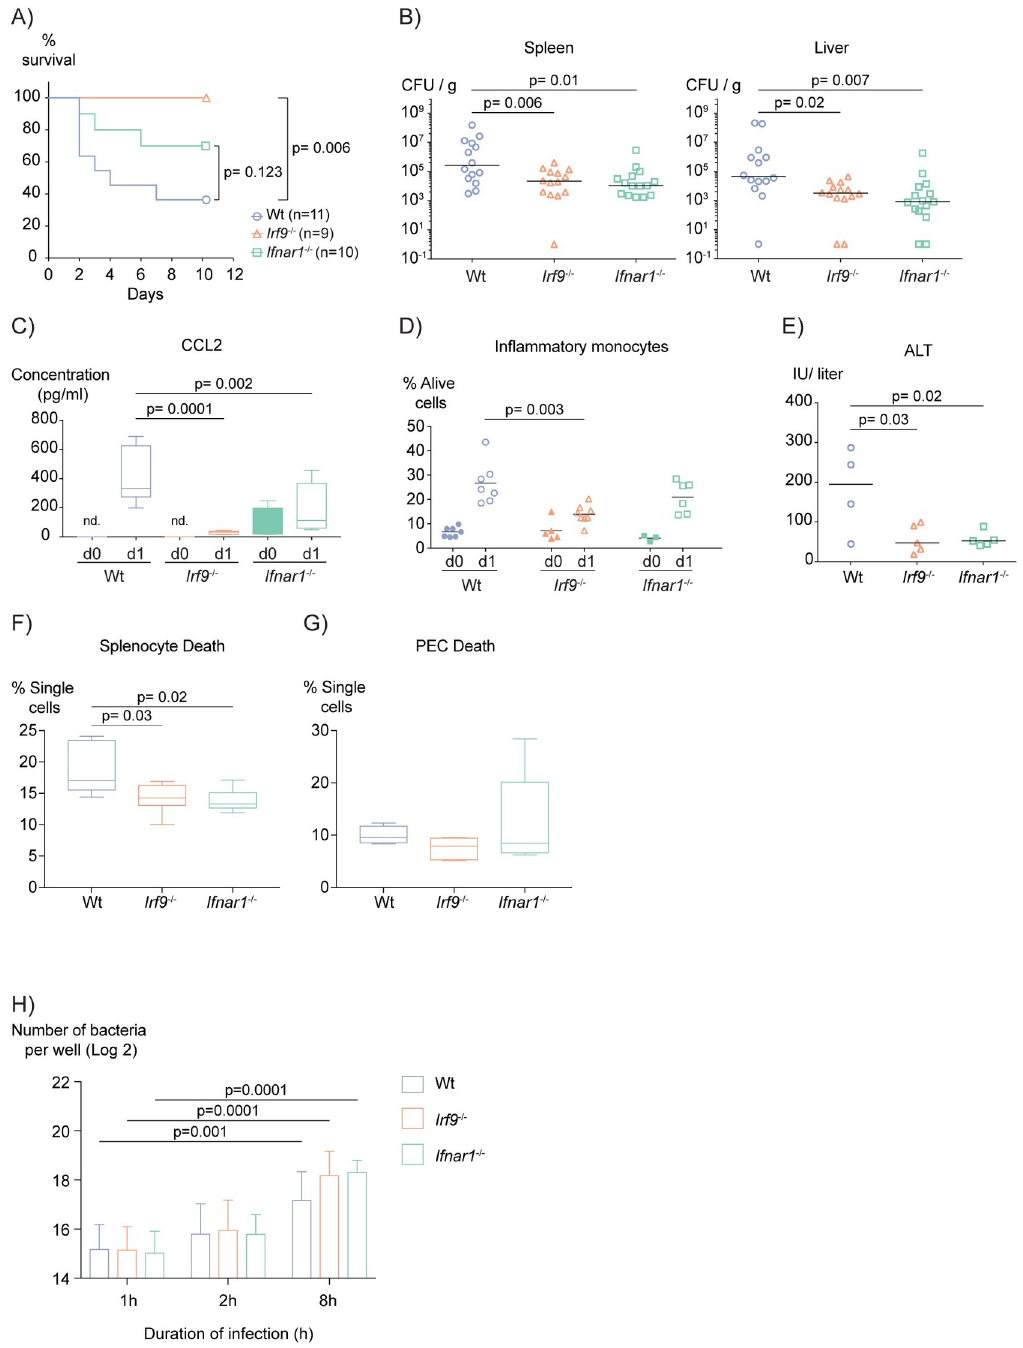
Fig 1. Irf9 -/- and Ifnar1 -/- mice differ in the level of protection from L . monocytogenes infection. (A) Kaplan-Meier plots showing survival of mice after infection with 10 6 L . monocytogenes for 10 days. P values were calculated using log-rank test and corrected for multiple testing using Bonferroni-Holm correction. (B) Bacterial loads of spleen and liver three days post- infection. (C) CCL2 levels measured from the plasma of mice one day after PBS injection or L . monocytogenes infection using Luminex-based multiplex bead array. The figure shows the pool of two experiments (Number of uninfected mice used wt = 10; Irf9 -/- = 10; Ifnar1 -/- = 8 and one-day infected mice wt = 9; Irf9 -/- = 9; Ifnar1 -/- = 8) (D) Flow cytometric analysis of inflammatory monocytes derived from peritoneal lavage of mice one day after PBS injection or L . monocytogenes infection. (E) Alanine aminotransferase (ALT) levels measured in plasma three days post-infection. (F) Percentage of total splenocyte (n = 6 for all genotypes) and (G) PEC (n = 4, 5 and 6, respectively) death gated from single cells of mice one day post-infection,